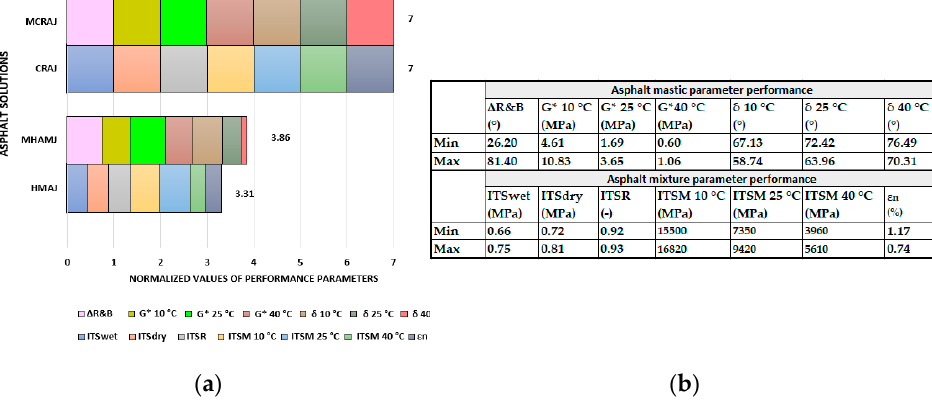
Figure 20. Comparison of solutions by normalizing the performance parameters: ( a ) performance diagram and ( b ) max and min values for each parameter performance.